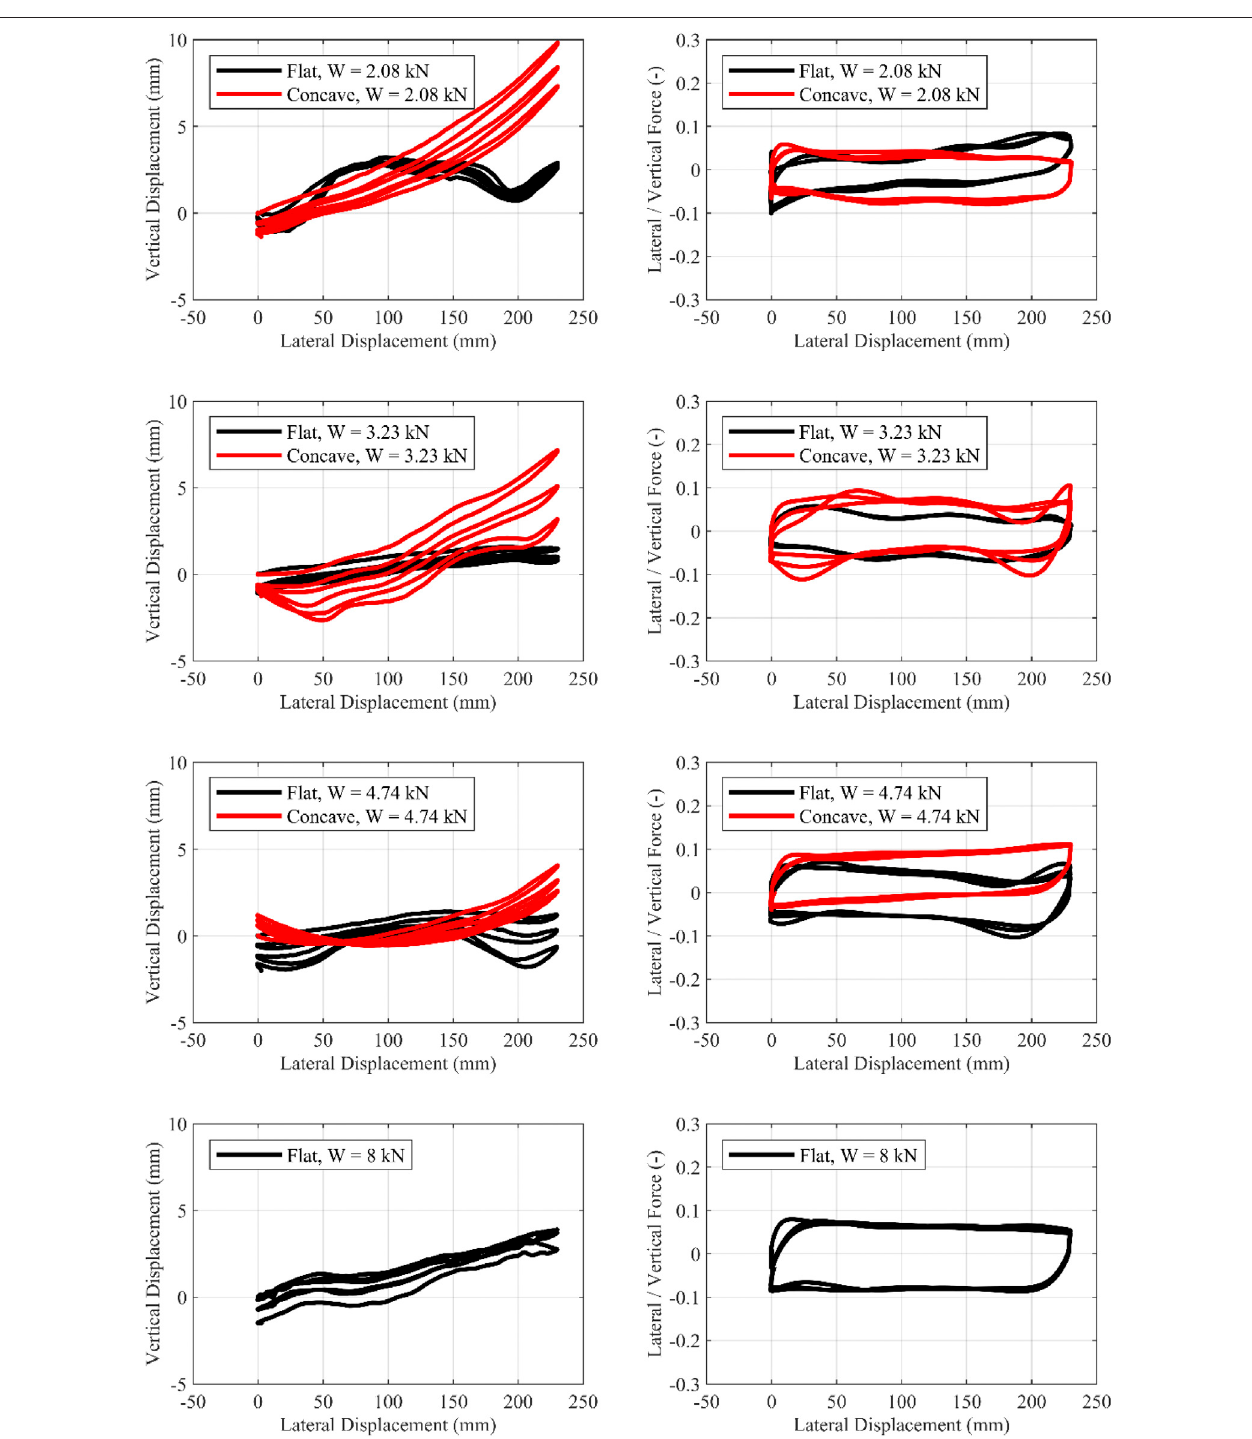
FIGURE 6 | Cyclic motion 0/+230 mm. In fl uence of the geometry of the concrete plates. Left , Vertical-horizontal displacement; Right , Lateral/Vertical force — Lateral displacement.